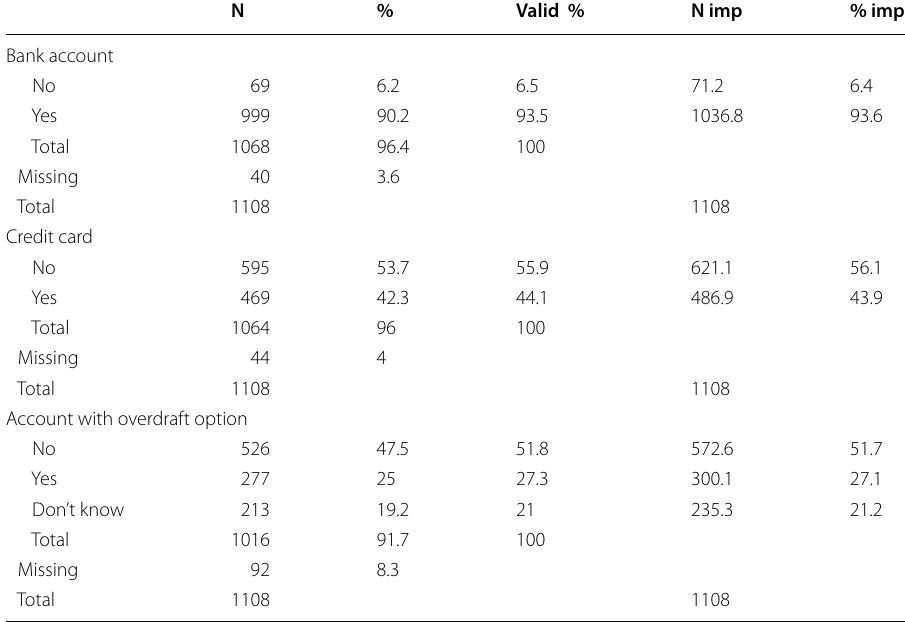
Table 3 Ownership of bank account and credit